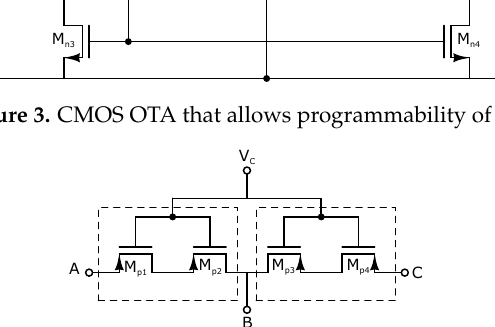
Figure 4. CMOS design of resistors R in Figure 3, allowing programmability of g m through V c .